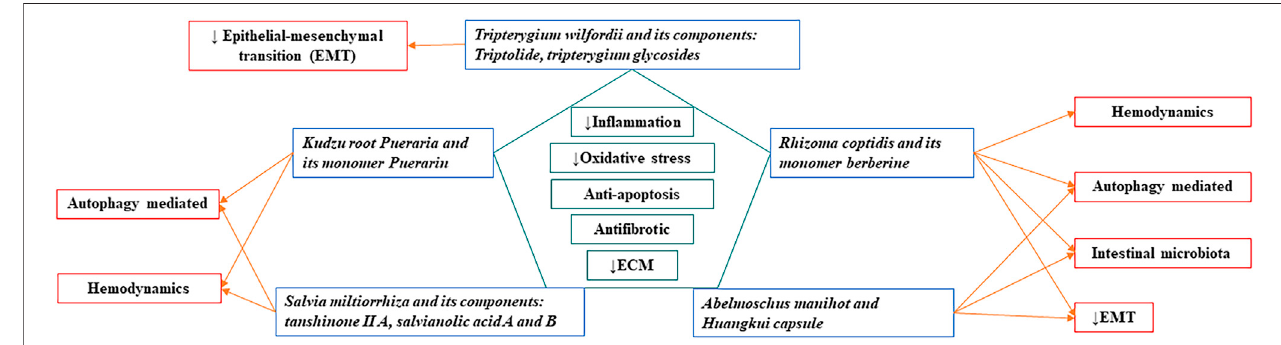
FIGURE 1 | Common mechanisms of Chinese herbal medicines in treating kidney